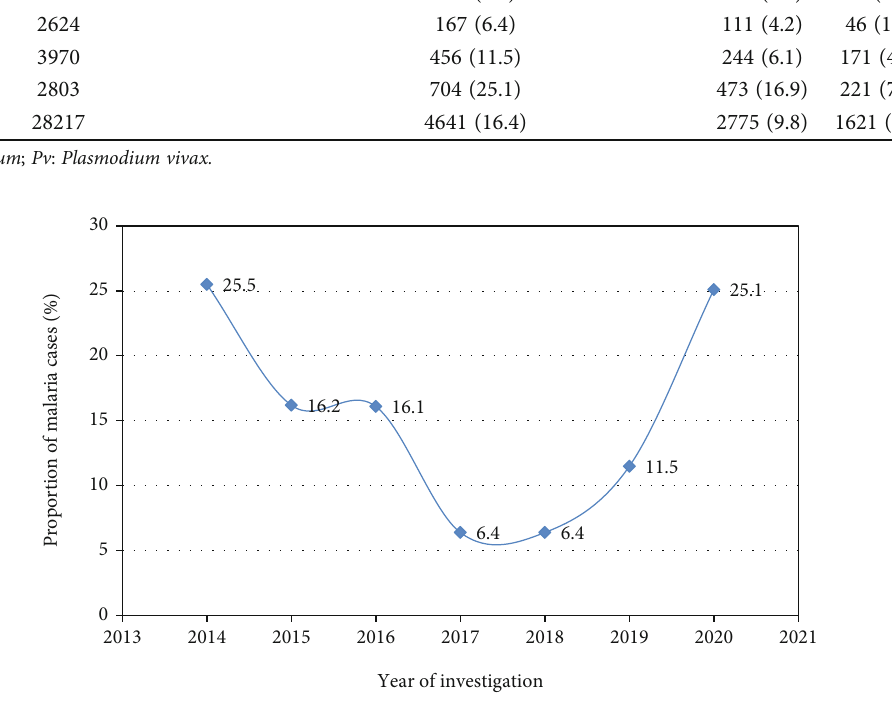
Figure 1: Trends of malaria prevalence in Maksegnit Health Center, northwest Ethiopia